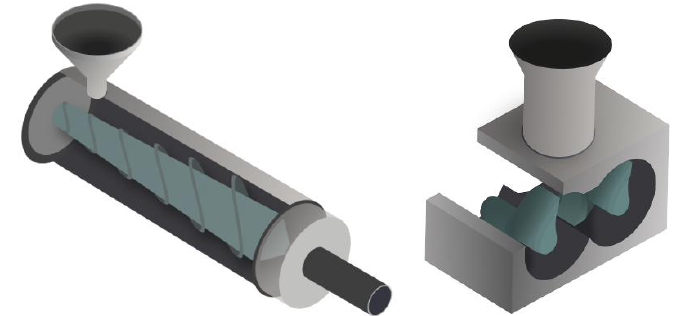
Figure 3. Extruder ( left ) and internal mixer ( right ) used to make solid polymer electrolytes. The polymer and the salt are often pre-mixed before their introduction into the chamber. Heating and high shear rates cause the polymer to flow allowing salt to be dissolved into it. This process is very interesting as it allows the polymer and the salt to be mixed in a few minutes as a result of high shear rates and the polymer being in its melt state.